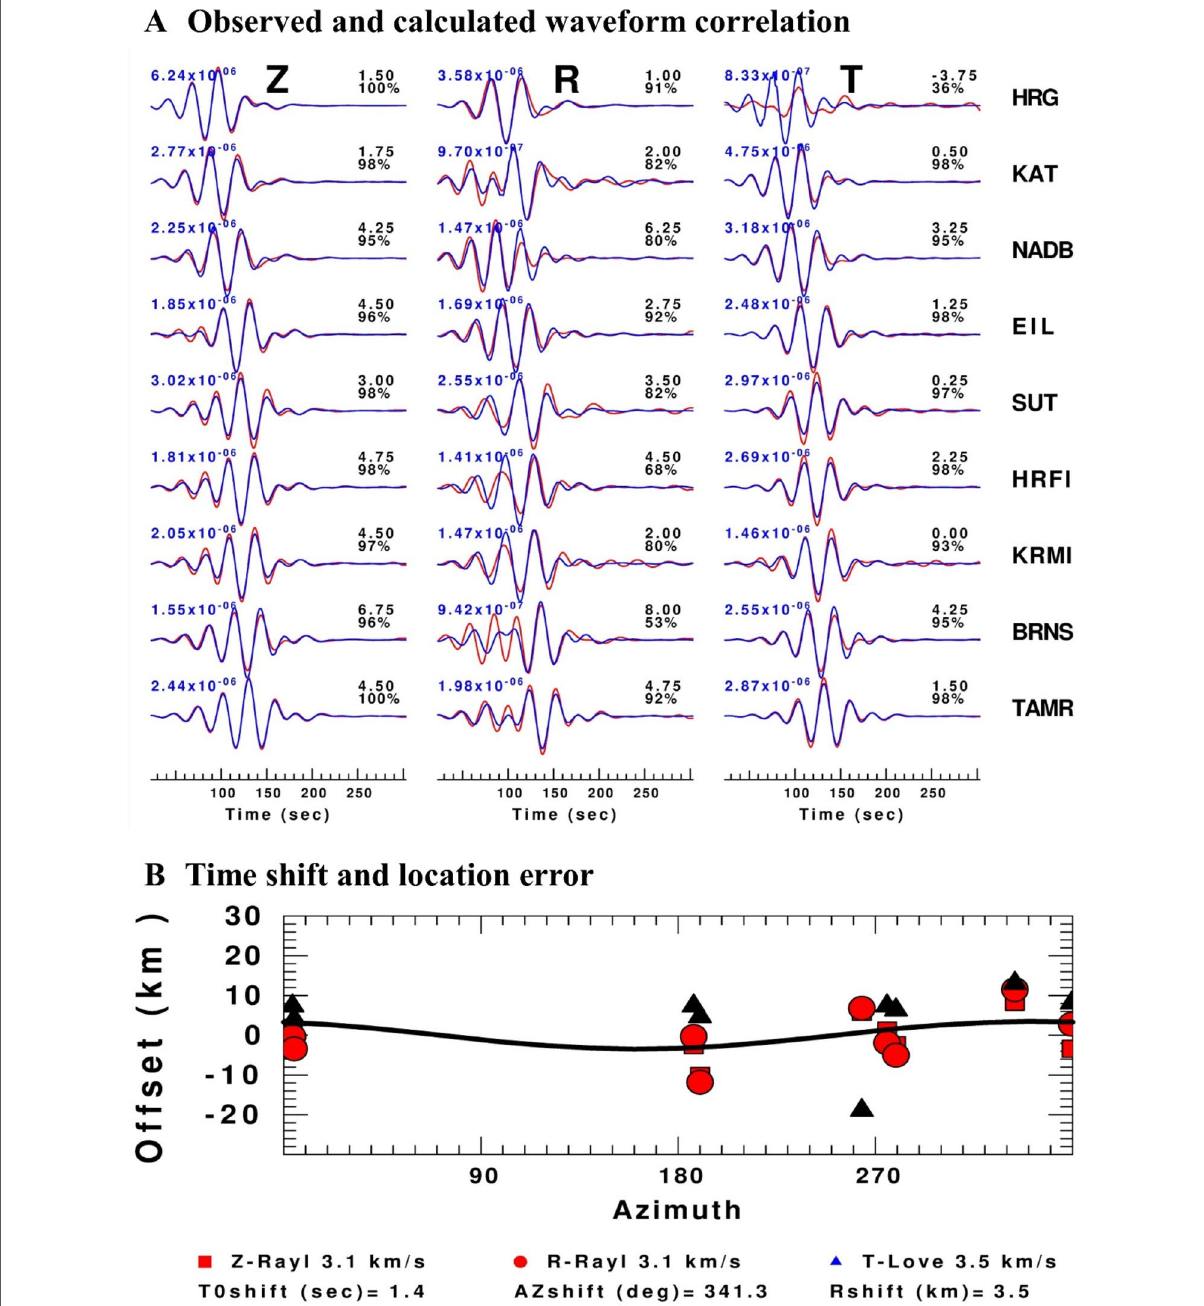
Fig. 6 A Synthetic and observed seismograms correlation of the current main shock of 16 Jun, 2020 northern Red Sea. B The time shift and location error of the inverted